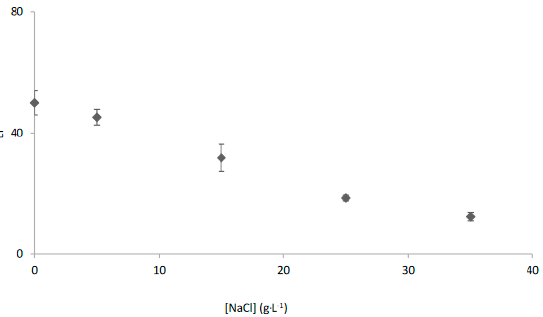
Figure 3. Salinity effect on the transport of Ag + with the EME system and Cyanex 471x in kerosene as organic phase.